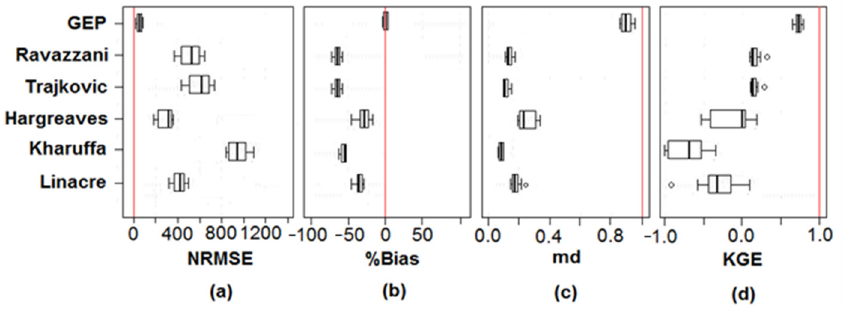
Figure 5 . Box plot of ( a ) normalized root mean square error (%), ( b ) percentage bias, ( c ) modified index of agreement, and ( d ) Kling-Gupta efficiency in estimating ET by different empirical models. The vertical red line in the plot indicates the ideal line.